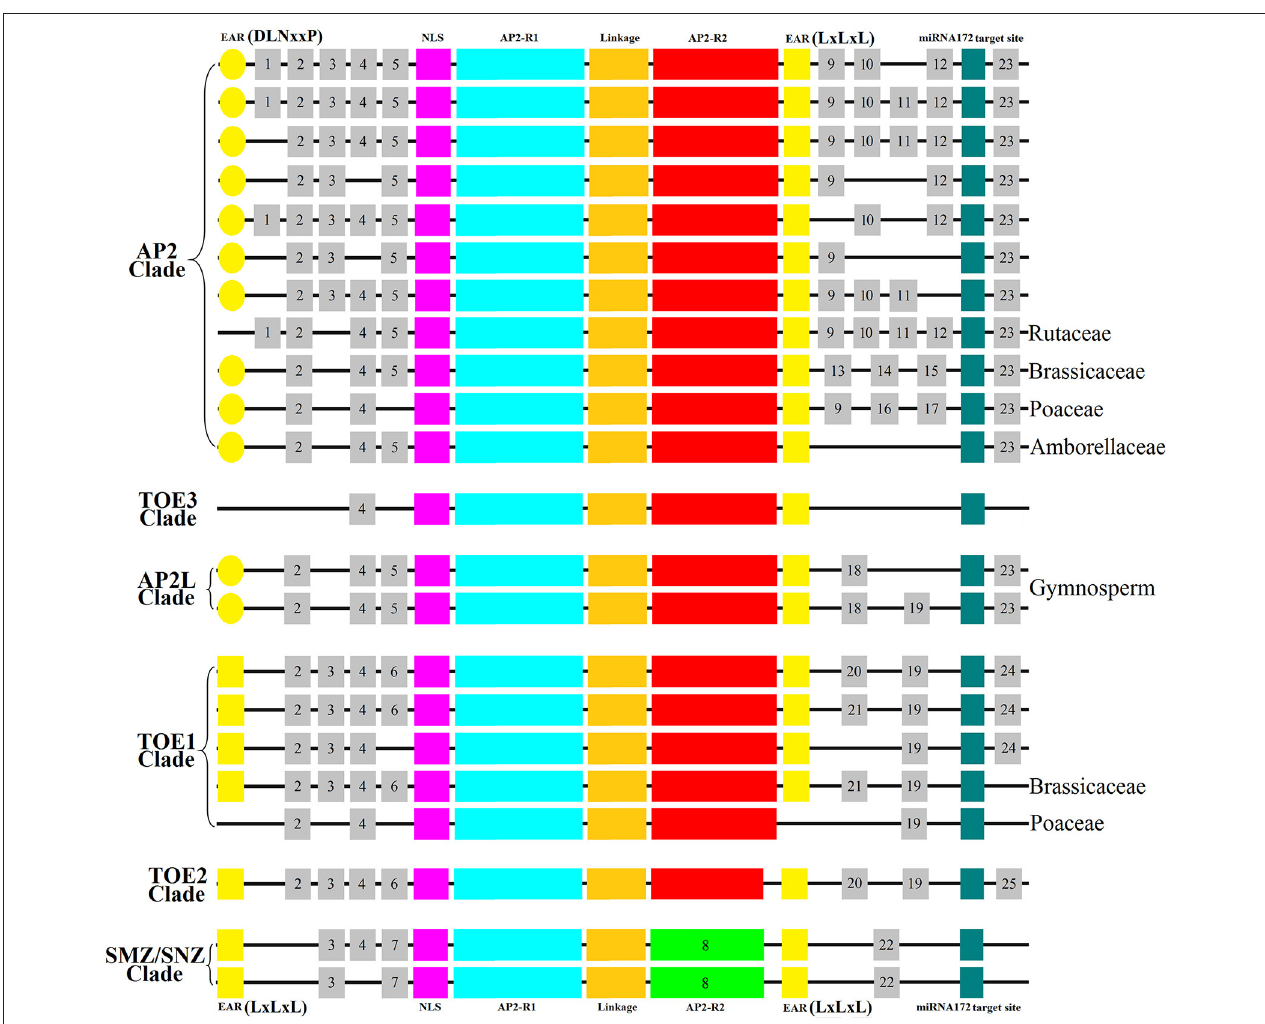
FIGURE 2 | Distribution of Homeodomains and Motifs of AP2 Group in Spermatophyte. A schematic representation of motifs obtained using MEME within the sequences is displayed. The homeodomains (EAR domain, NLS domain, AP2-R1 domain, linkage domain; AP2-R2 domain, miRNA172 target site) were showed by the same colors with Image 1 . The different motifs were indicated by using